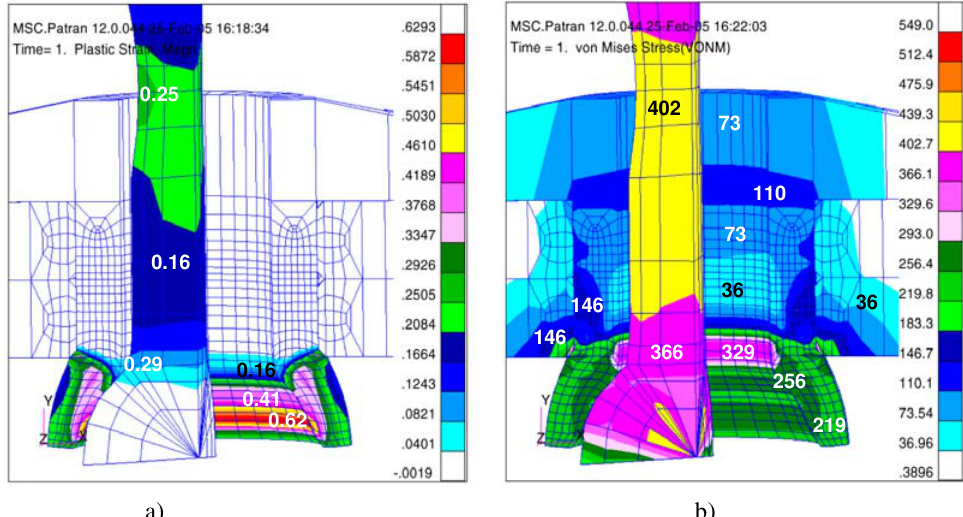
Fig 5. The plastic strain (a) and Von Mises stress (b) distribution in the final phase of riveting (displacement of core – 2 mm)